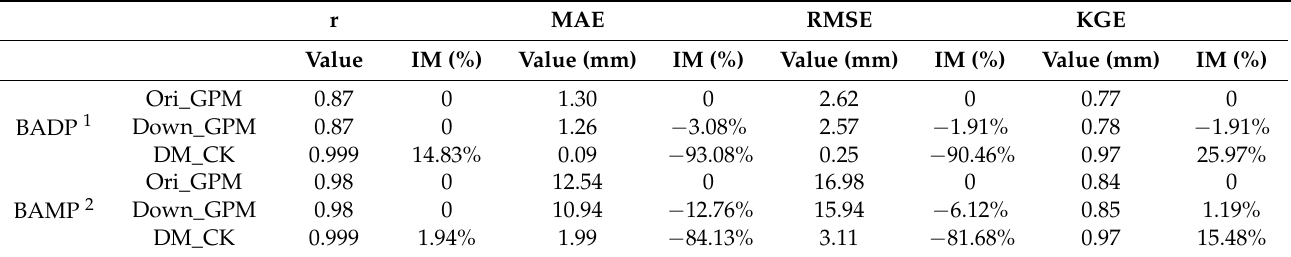
Table 6. Evaluation for categorical indices of BADP from the Ori_GPM, Down_GPM, and DM_CK in identifying the no-rain events over the study area from March 2016 to February 2018.